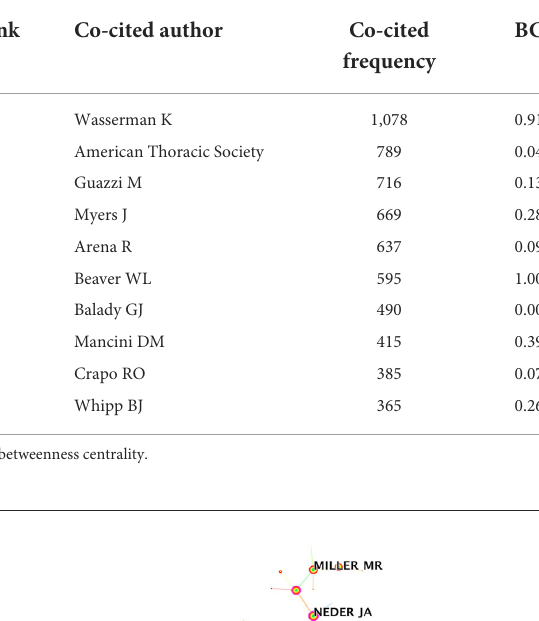
TABLE 5 Top 10 authors ranked by co-cited frequency on CPET publications.